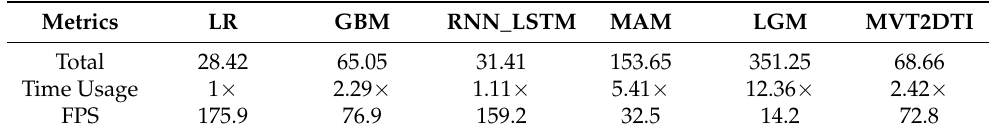
Table 3. The comparison of model processing speed in seconds.